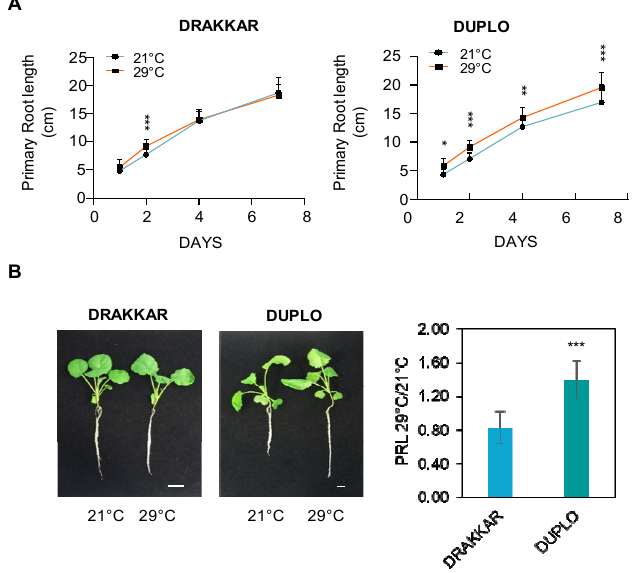
Figure 2. B. napus primary root differentially responds to warm temperatures. ( A ) Dynamics of primary root growth in Drakkar and Duplo varieties grown at 21 ◦ C and 29 ◦ C. Graph represents means for 3 independent biological replicates. Statistical t -test analysis * p < 0.01, ** p < 0.001, *** p < 0.0001. ( B ) Ratio of root length and representative images of Drakkar and Duplo root phenotypes of 15-day-old seedlings grown at 21 ◦ C and 29 ◦ C in perlite pots. The ratios were similar to the values previously reported at 7 days. Scale bars, 5 cm. Statistical t -test analysis *** p < 0.0001.